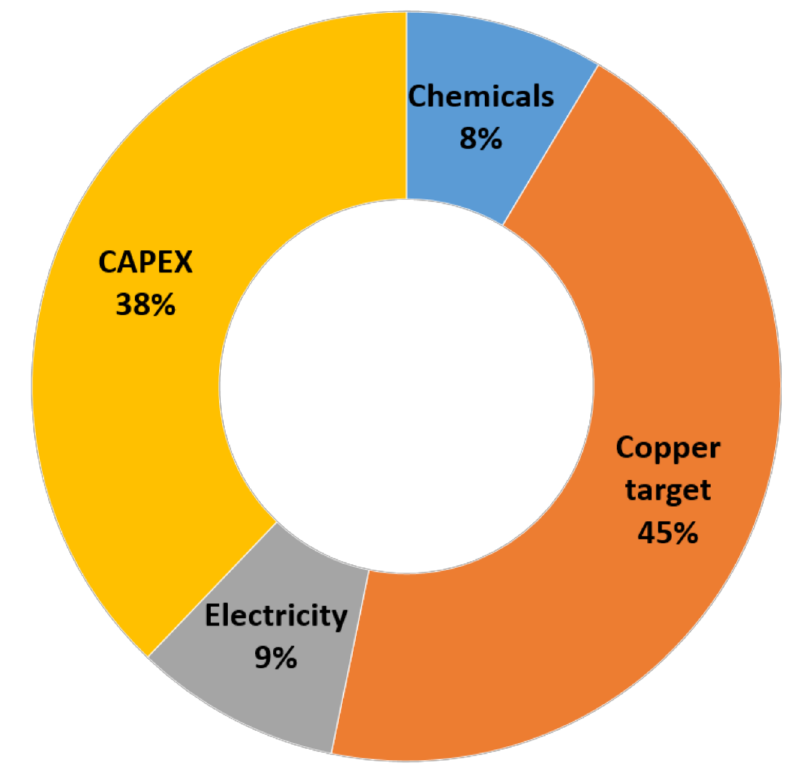
Figure 13. Cost structure of PCL-Cu facemask